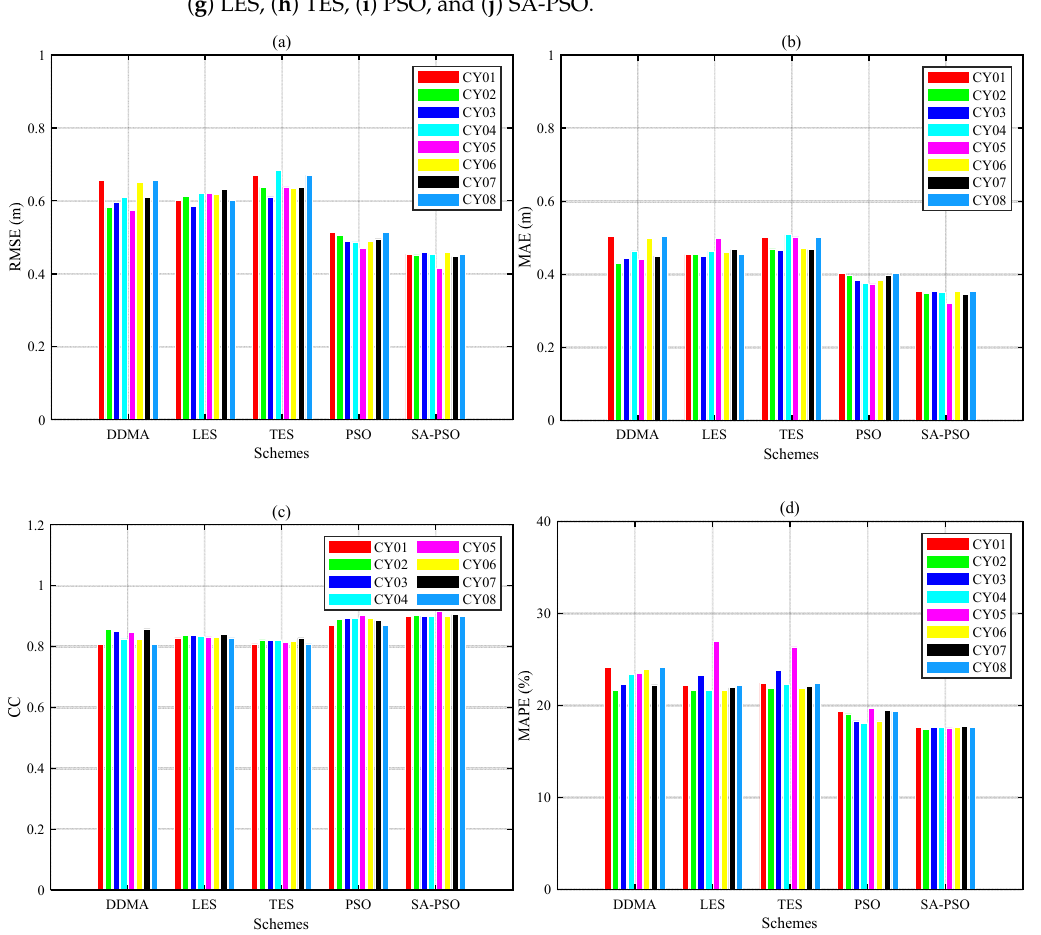
Figure 9. ( a ) RMSE, ( b ) MAE, ( c ) CC, and ( d ) MAPE statistics of the swell height retrieval results of eight CYGNSS satellites compared with ERA5 swell height